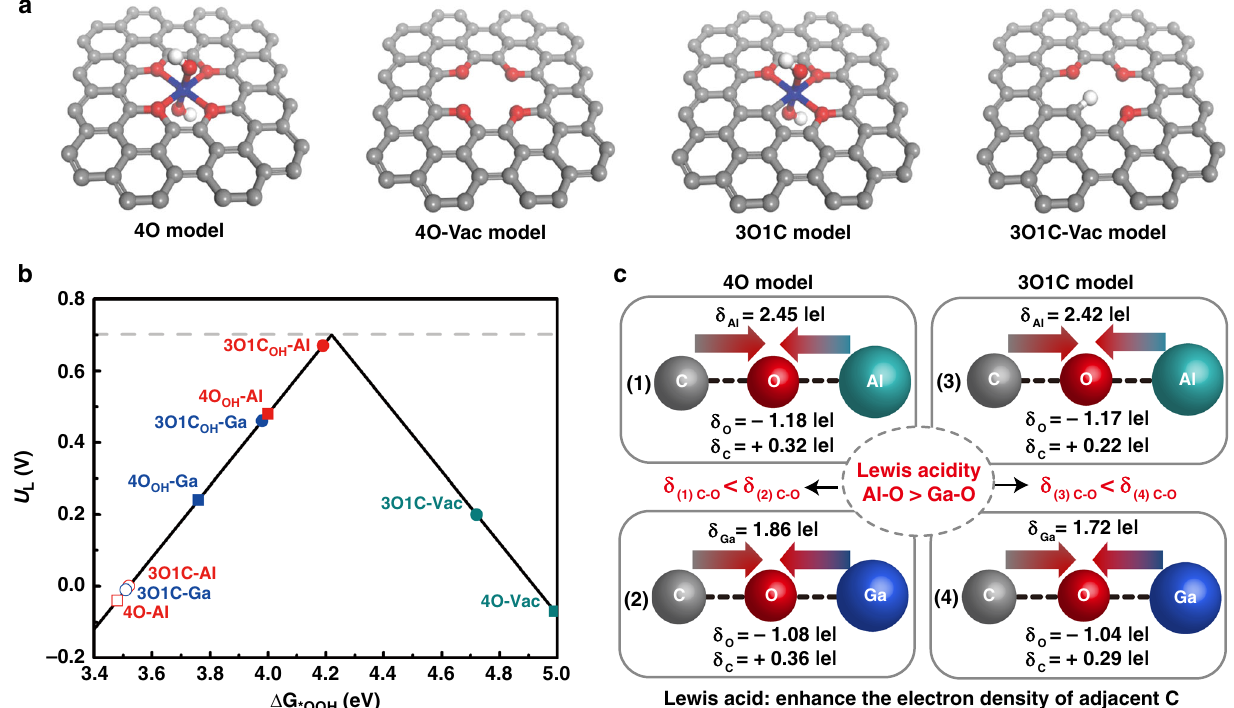
Fig. 1 The atomically dispersed Lewis acid in an oxygen-rich carbon catalyst enhanced the catalytic performance of the 2-electron ORR reaction. a Four DFT calculation models with potential active sites for electrochemical production of H 2 O 2 . Blue, red, white, and gray balls denote metal, O, H, and C atoms, respectively. b The simulated activity volcano plot for 2-electron ORR path to H 2 O 2 . The theoretical equilibrium potential is shown as a gray dashed line. c Illustration showing the effect of Lewis acidity to the electron distribution of adjacent carbon